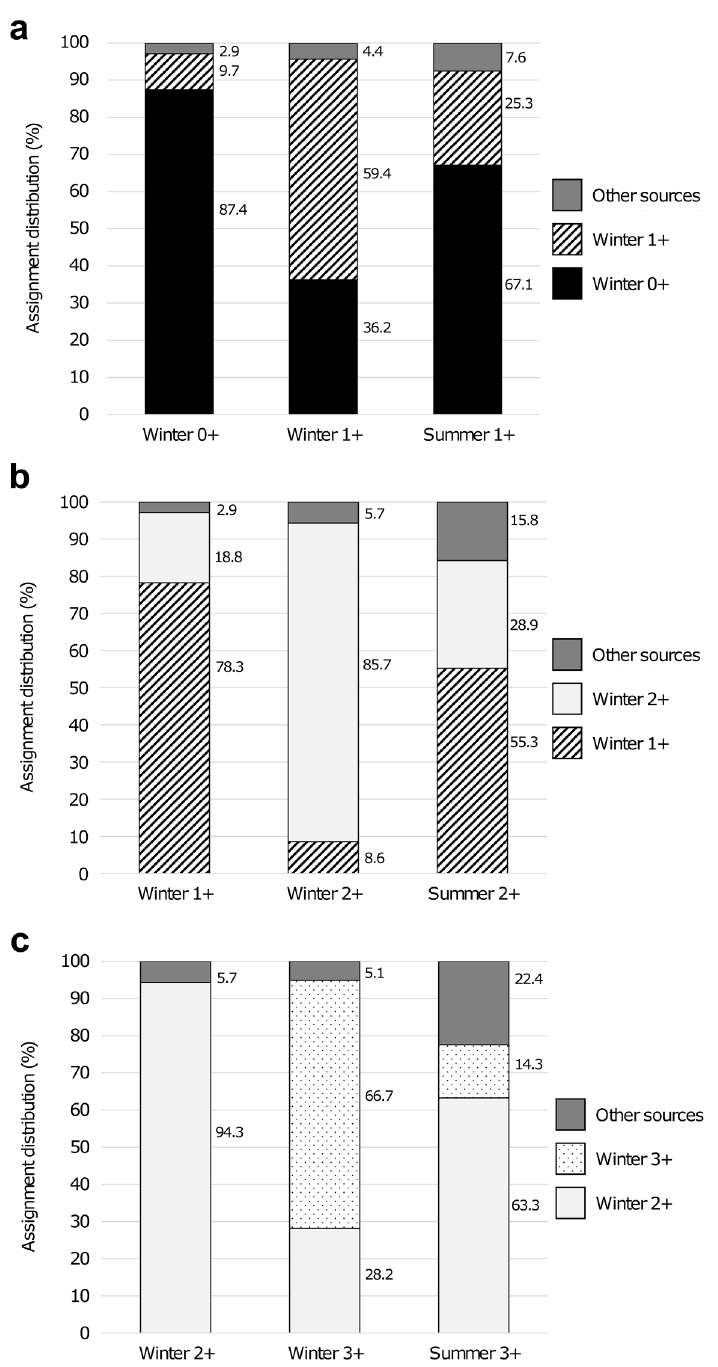
Figure 7. Assignment distribution (%) of A. antennatus female summer groups up to 3+ derived from the modal progression analysis (MPA) to their closest winter baselines: summer 1+ ( a ), summer 2+ ( b ) and summer 3+ ( c ).